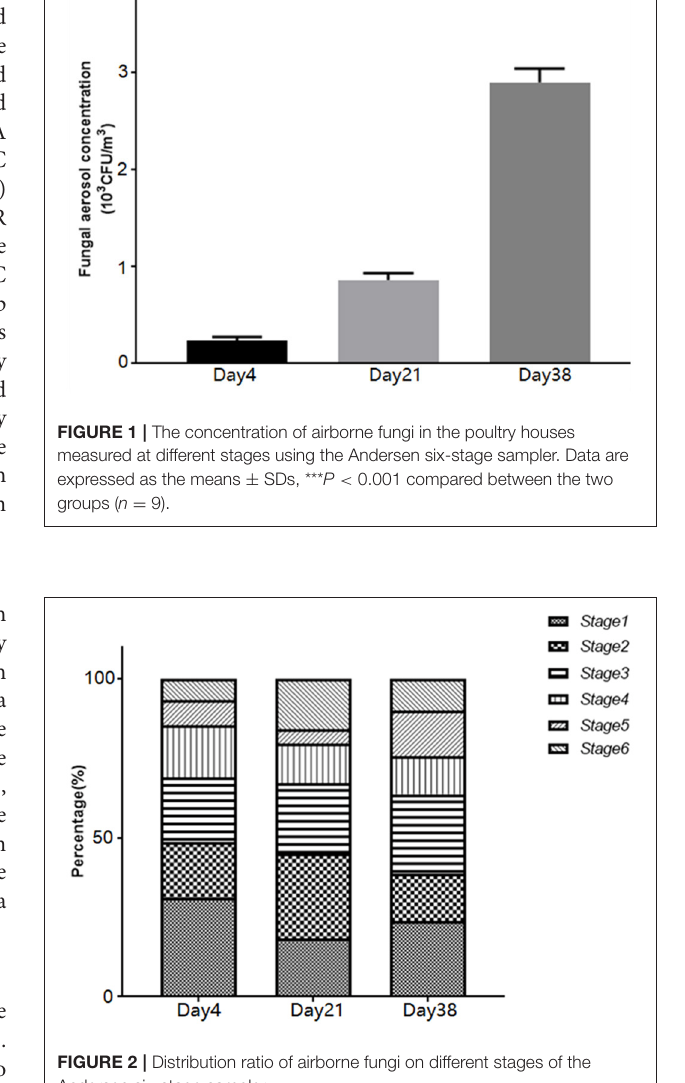
FIGURE 2 | Distribution ratio of airborne fungi on different stages of the Andersen six-stage